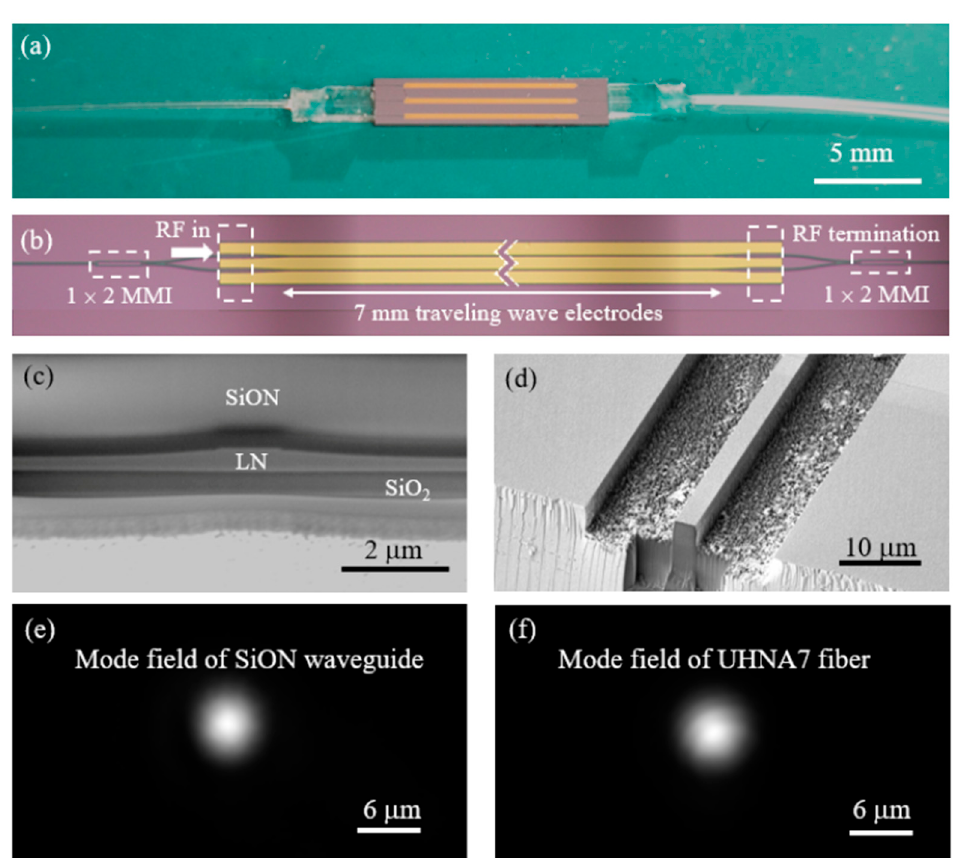
Figure 3. ( a ) Photograph of a fabricated electro-optic (EO) modulator bonded with fiber arrays. ( b ) The microscope image of the EO modulator part of the chip. ( c ) The SEM image of the cross section of the fabricated thin-film LN waveguide. ( d ) The SEM image of the SiON waveguide. ( e ) The mode field profile of the SiON waveguide. ( f ) The mode field profile of the commercial UHNA7 fiber.